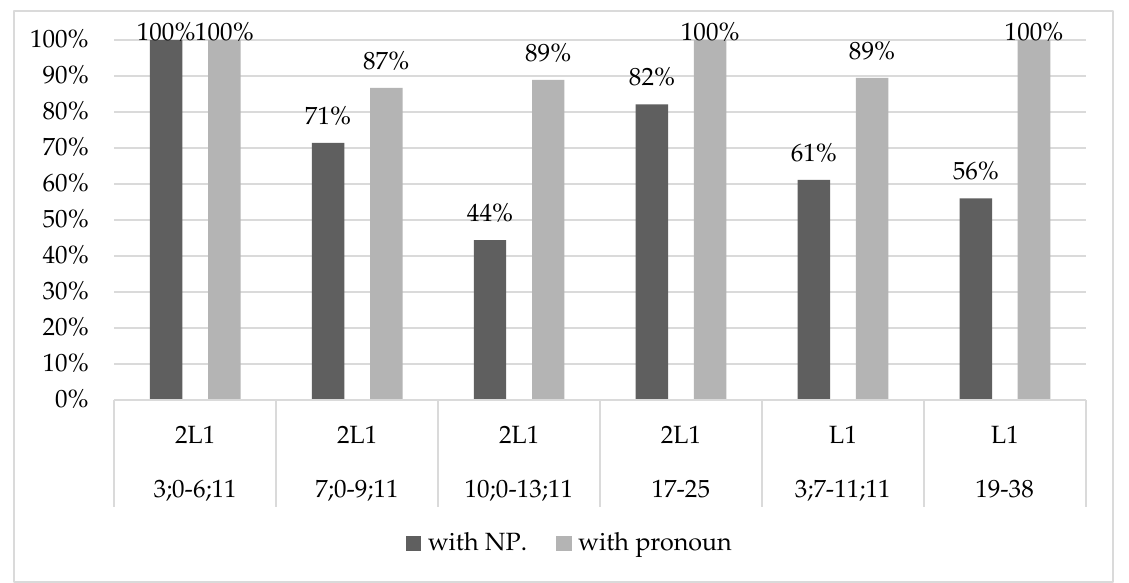
Figure 7. Acceptance of discontinuous word order in verb phrases with noun phrases (NPs) vs. pronouns in simultaneous bilinguals (2L1) and monolinguals (L1).